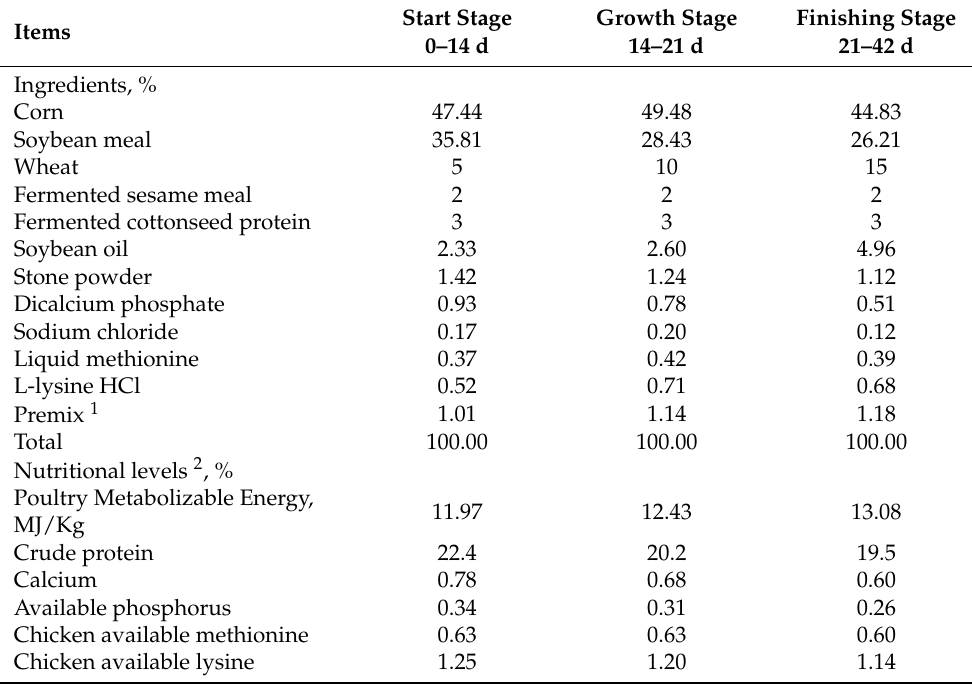
Table 1. Composition and nutrient levels of the basal diets (air-dry basis).